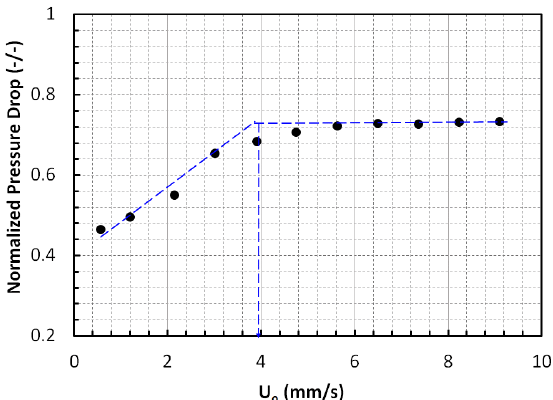
Figure 11. Minimum fluidization velocity from the overall pressure drop profile of the defluidization cycle.